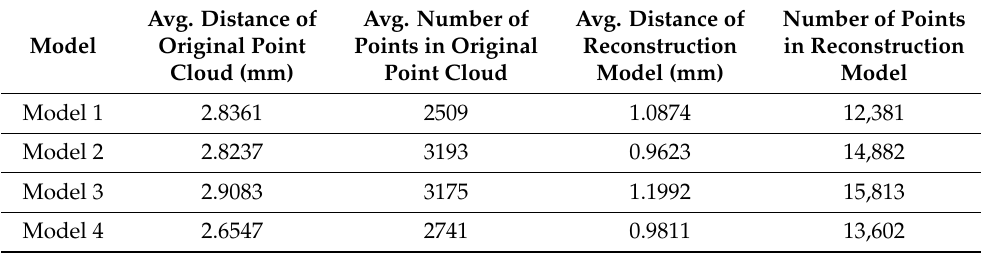
Table 1. Comparison between the original point cloud and reconstruction model.